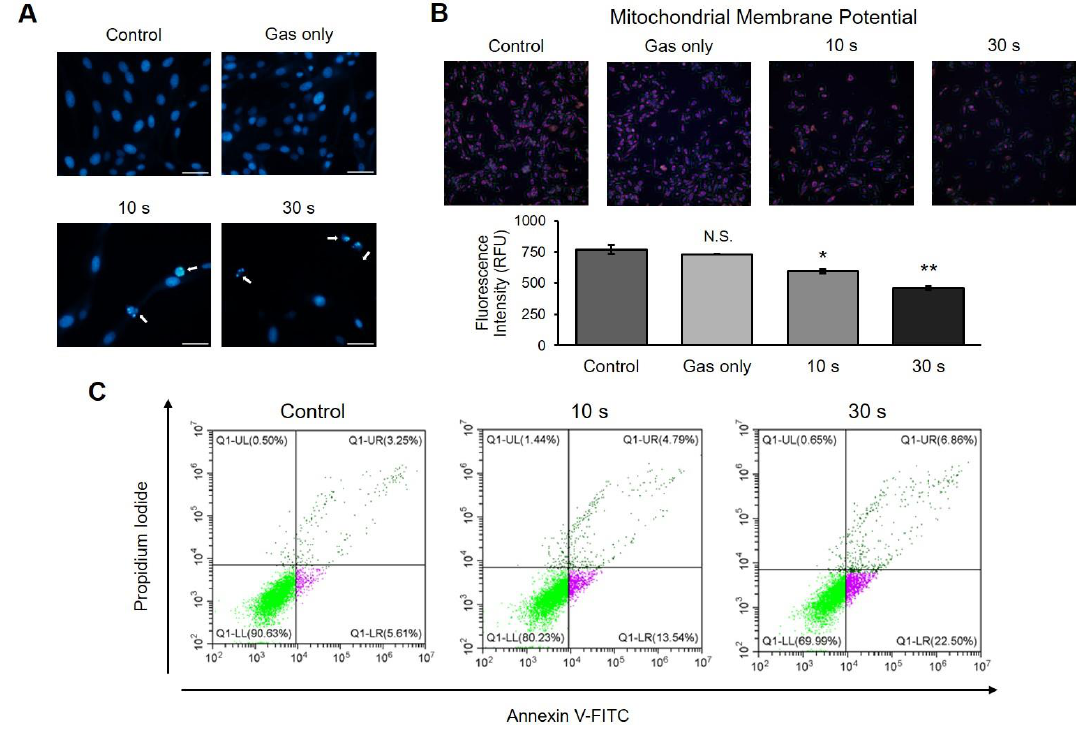
Figure 4. Induction of apoptosis by cold atmospheric plasma (CAP) on canine osteosarcoma cells. ( A ) Microscopy analysis of chromatin condensation. Cells were stained with 4′,6-diamidino-2-phenylindole (DAPI) and observed under a fluorescence microscope. Apoptotic nuclei were detected in CAP-treated wells. Scale bars, 50 μm. ( B ) Measurement of change in mitochondrial membrane potential (Δ ψm). The cells were stained with MitoTracker, which is a stain for the mitochondrial membrane, and the intensity was measured by high-content screening technology. CAP-treated cells showed decreased Δ ψm compared to that in control. Error bars represent the mean ± S.E.M. of three